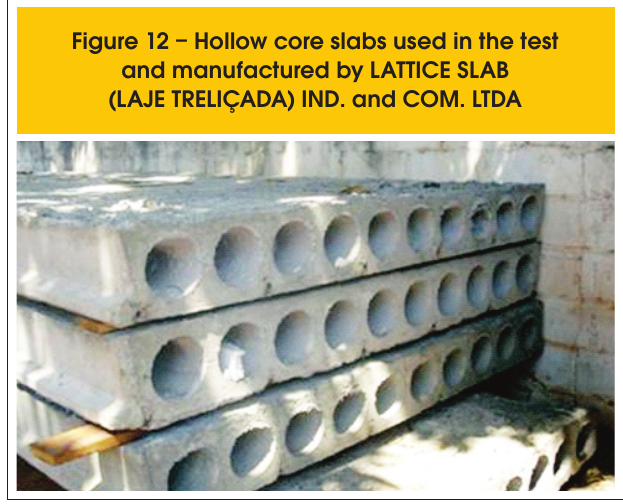
Figure 13 – Panoramic view of the test